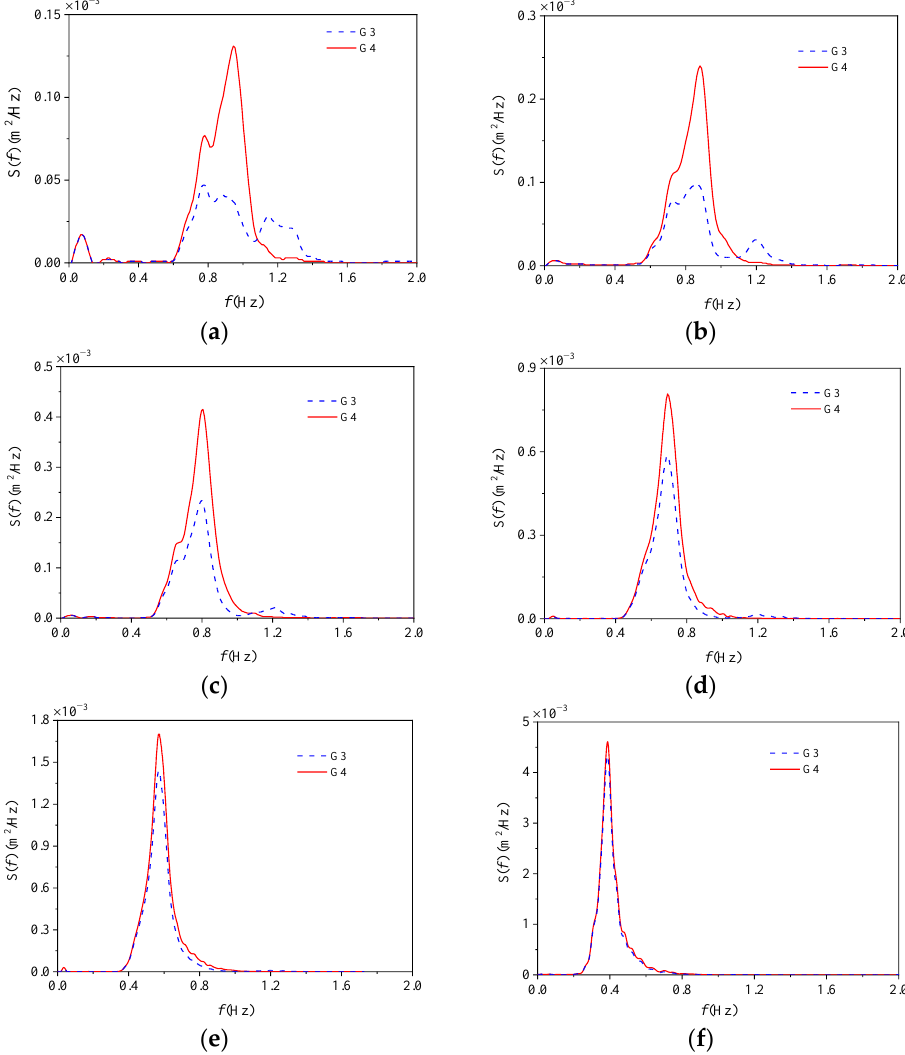
Figure 14. The comparison of free surface elevation spectra at the chamber interior for G3 and G4. ( a ) k p h = 3.010, ( b ) k p h = 2.578, ( c ) k p h = 2.186, ( d ) k p h = 1.700, ( e ) k p h = 1.258, ( f ) k p h = 0.750.